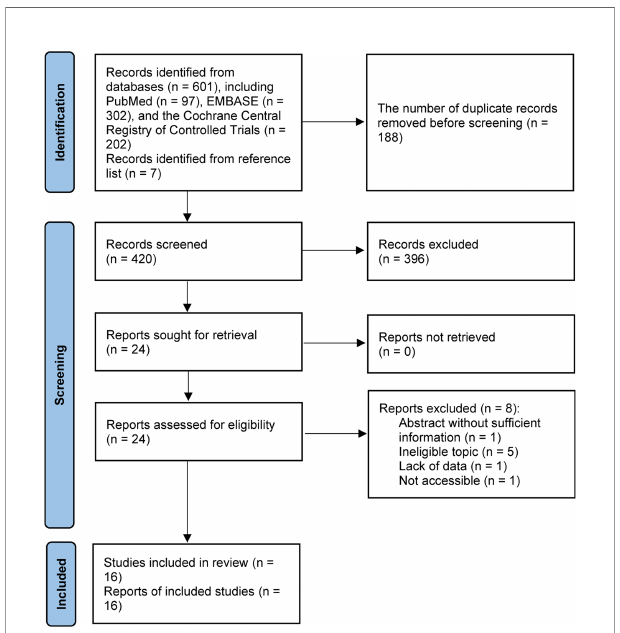
FIGURE 1 | Flow chart for the literature search and study